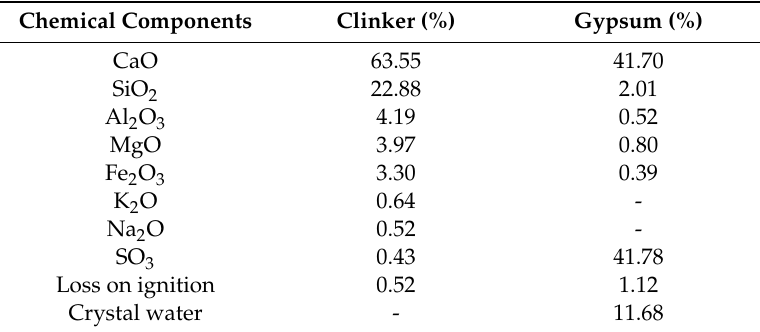
Table 1. Chemical compositions of cementitious materials.